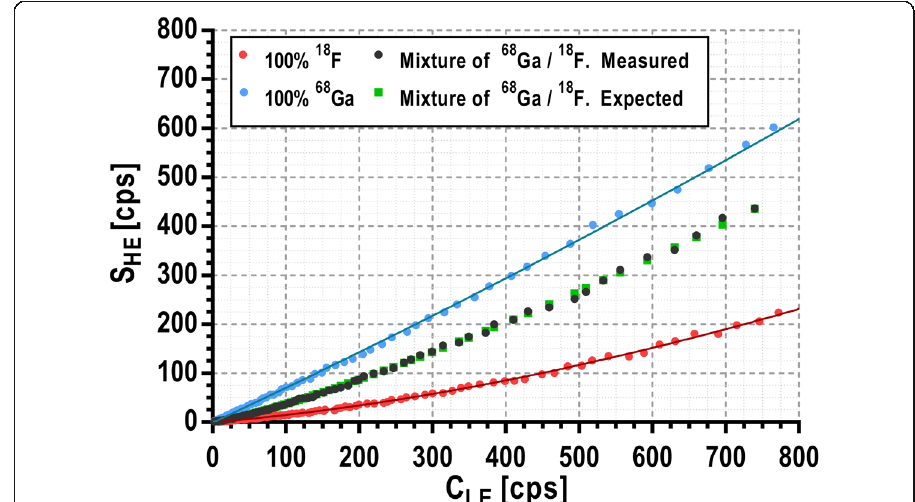
Fig. 6 Single rates within the high-energy window ( S HE ) as a function of the coincidence rate within the low-energy window ( C LE ) for measurements performed with pure 18 F (red dots), pure 68 Ga (blue dots), and a mixture of both radioisotopes (black dots). The results for the pure samples were fitted to a third-degree polynomial (blue and red lines for pure 68 Ga and 18 F respectively). These fits are used as the calibration curves named as S HE,F and S HE,Ga in Eq. (2). Green squares represent the expected values for the mixture obtained using Eq. (2) and the theoretical relative activity ( a Ga,A